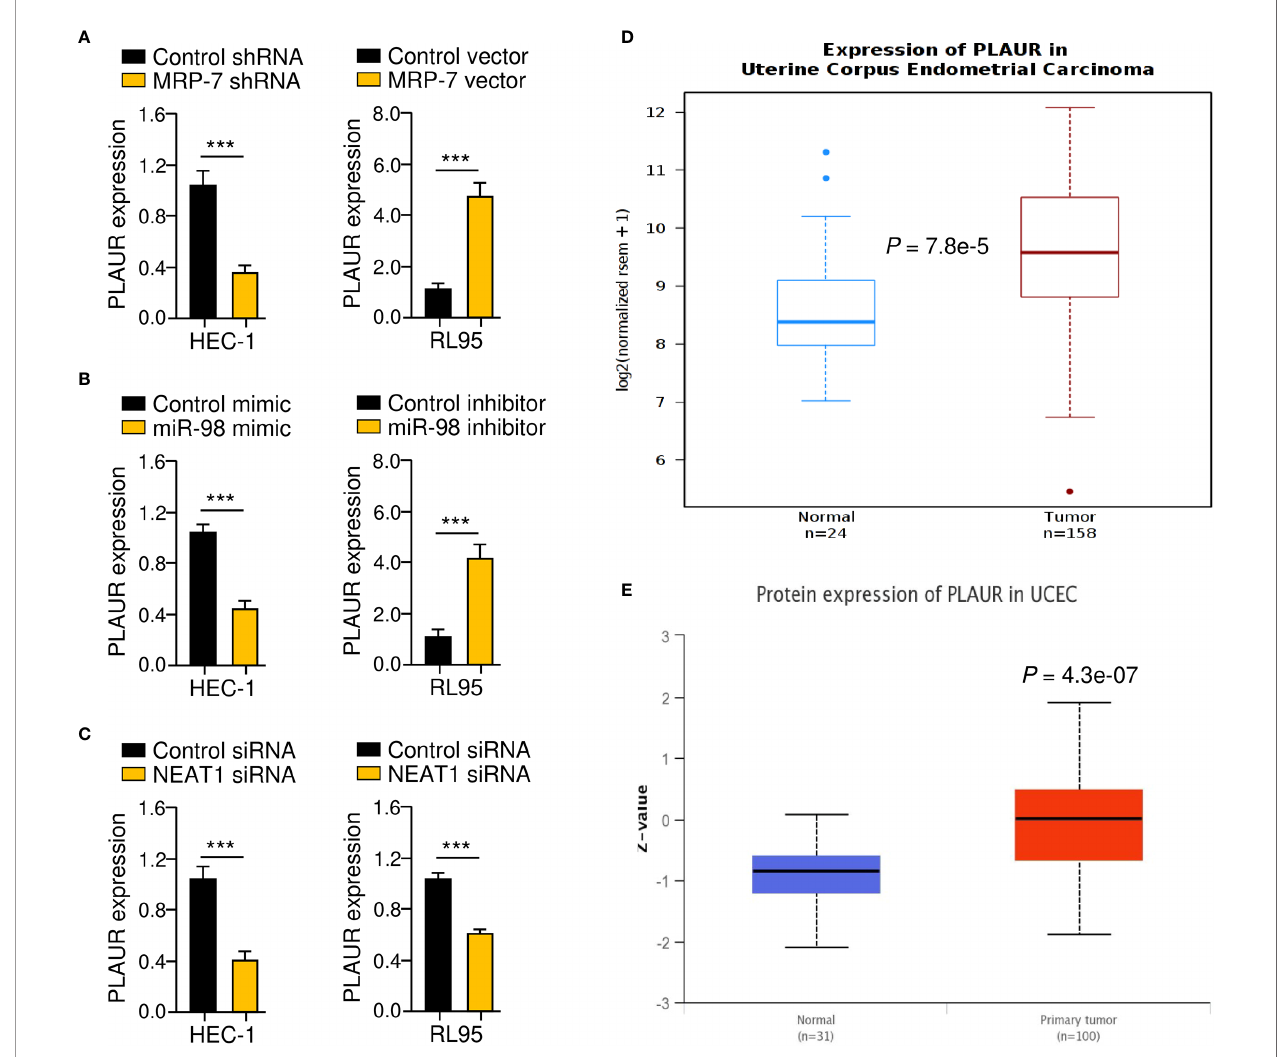
FIGURE 9 | Identi fi cation of PLAUR as a Downstream Effector of the NEAT1/miR-98/MRP-7 Pathway. (A – C) The qRT-PCR analysis of PLAUR expression in EC cells transfected with MRP-7 shRNA or MRP-7 expression vector (A) , in EC cells transfected with miR-98 mimic or miR-98 inhibitor (B) , and in EC cells transfected with NEAT1 siRNA or control siRNA (C) . (D, E) The Wanderer database (D) and the UALCAN database (E) were used to examine PLAUR levels in TGA EC and normal tissues. *** P <